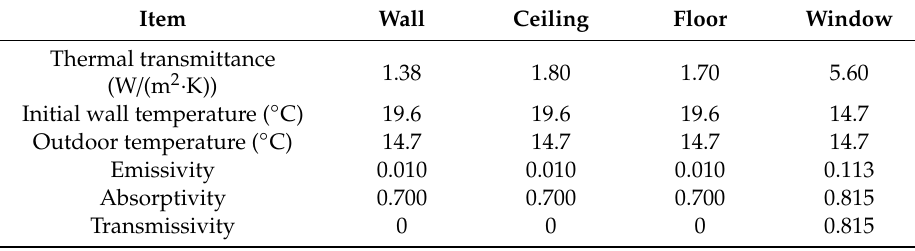
Table 2. Boundary conditions of the air conditioner.